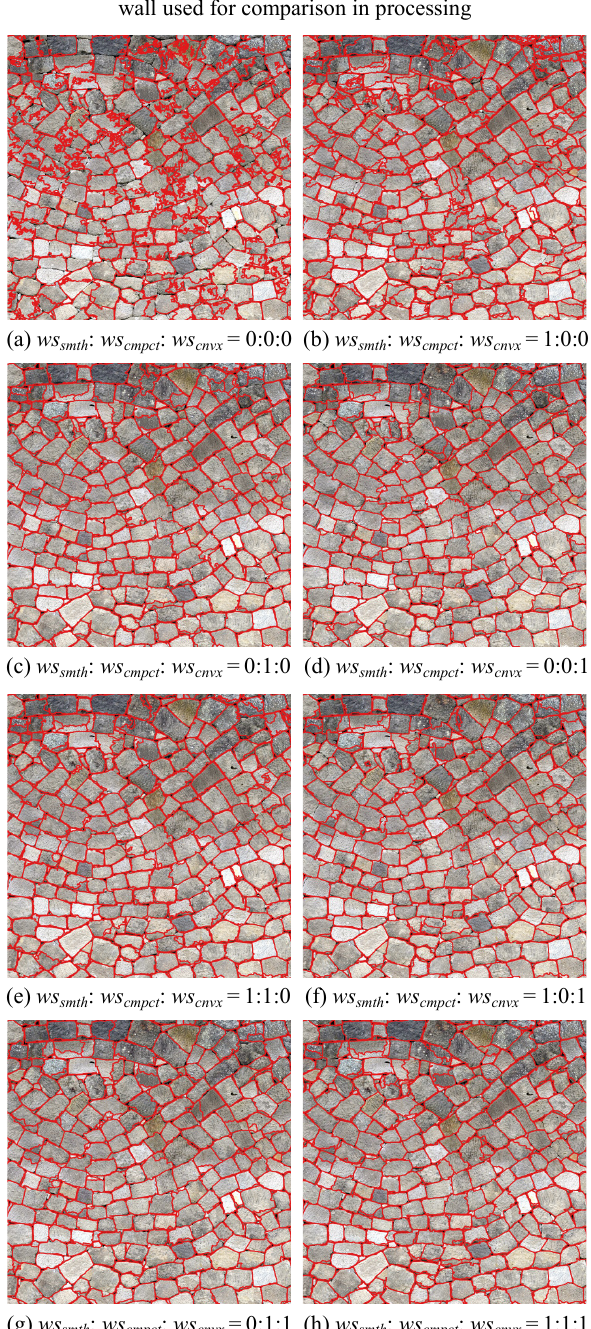
Figure 4. Image segmentation results by the different weights for combination of three shape